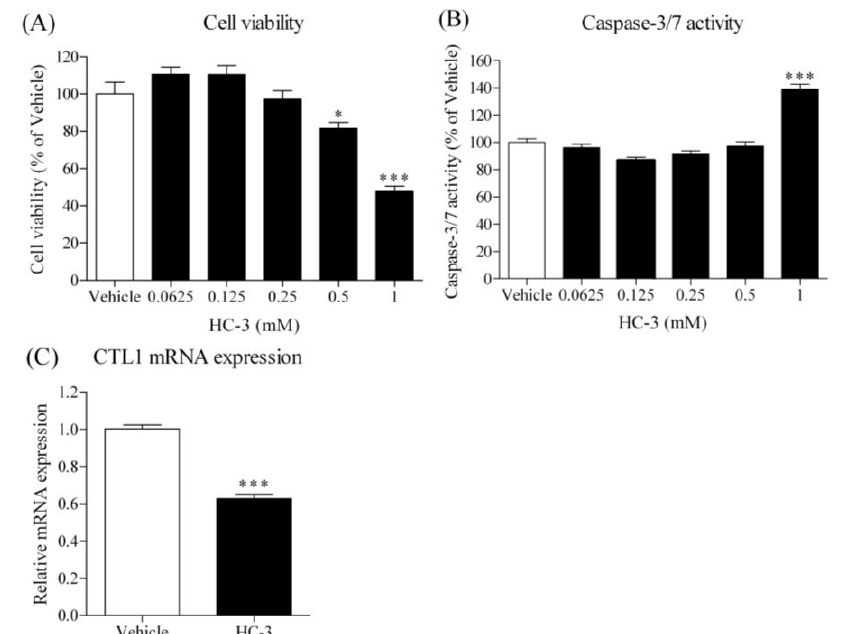
Figure 9. Effect of choline uptake inhibitor, HC-3, on cell viability, caspase-3/7 activity and CTL1 mRNA expression in HSC-3 cells. Cells were incubated with each concentration of HC-3 for 72 h, and then cell viability ( A ) and caspase-3/7 activity ( B ) were measured ( n = 4). * p < 0.05 and *** p < 0.005 compared to the vehicle control (Normal). ( C ) Cells were incubated with 1 mM HC-3 for 72 h, and then CTL1 mRNA expression was analyzed by real-time PCR ( n = 4). *** p < 0.005 compared to the vehicle control (Normal).